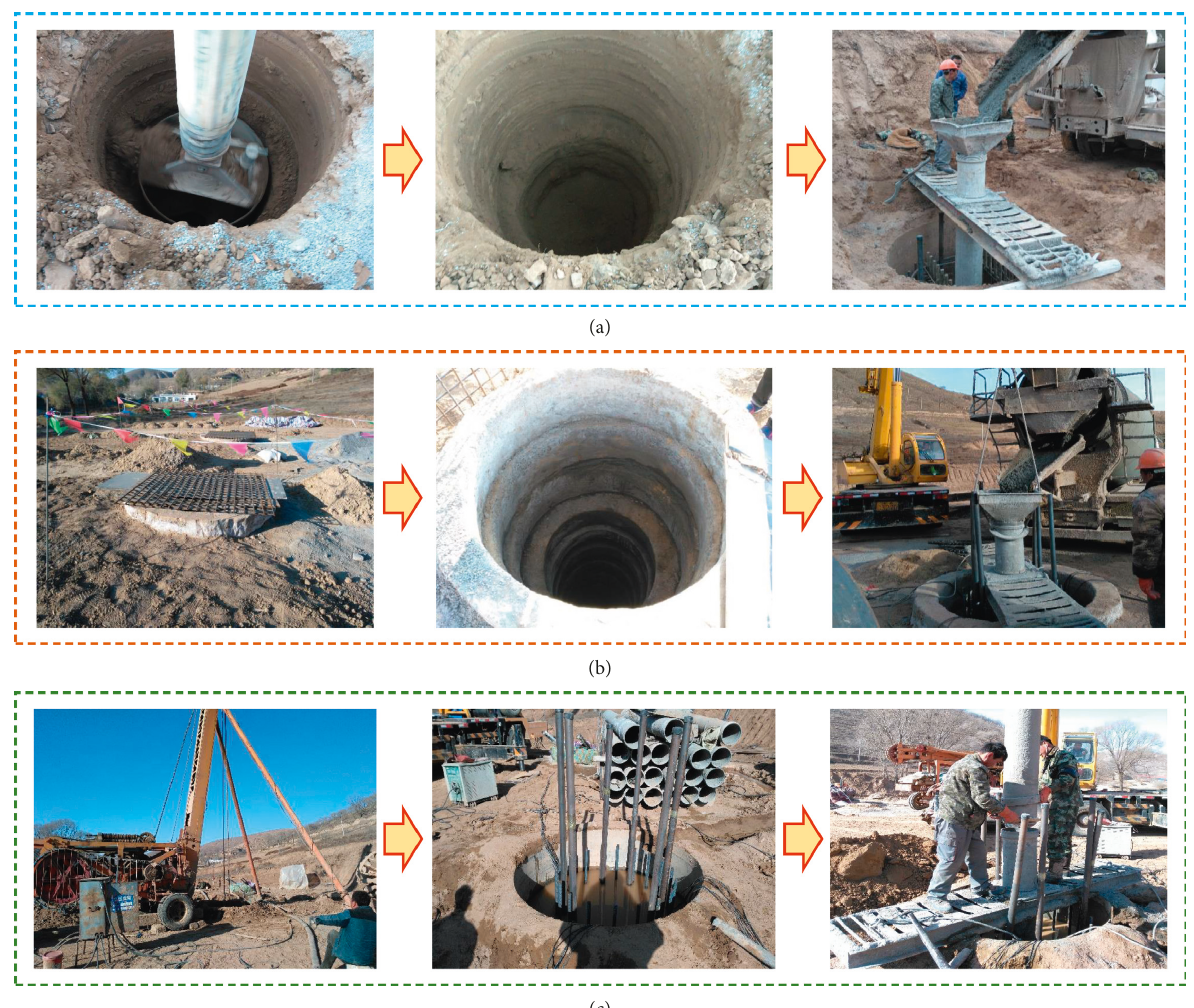
Figure 3: Construction process of the 3 test piles. (a) RDP. (b) MDP. (c)